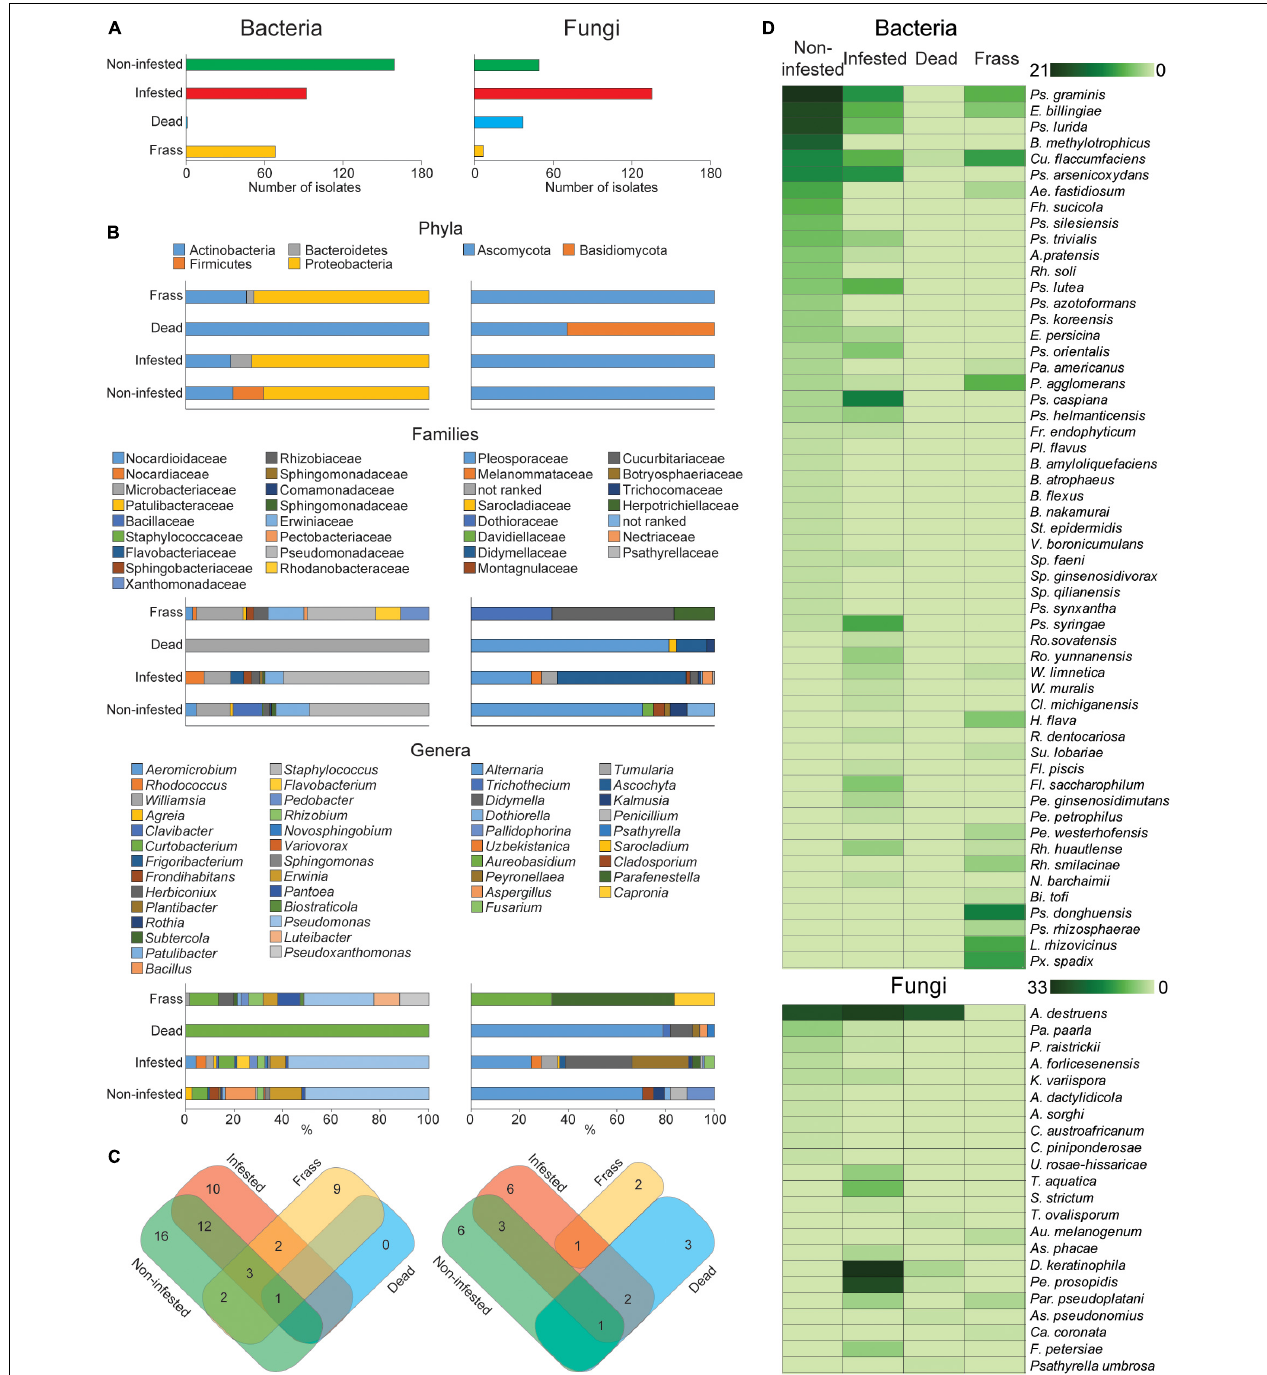
FIGURE 3 | Fungal and bacterial diversity and abundance in different wild apple twigs and larval frass. (A) Number of isolates of fungi and bacteria of different twigs and larval frass. (B) Percentage distribution of isolates by their phylum, family, and genus. (C) Venn diagram summarizing the composition of fungal and bacterial isolates at the species level. (D) Heat map analysis displaying a comparison of fungal and bacterial abundance by different twigs and larval frass.